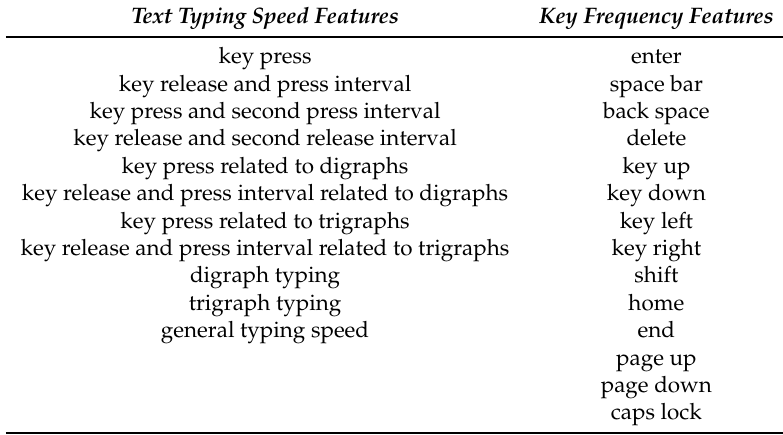
Figure 2. Architecture of the ANN for the sentiment analyzer agent with keystroke dynamic data. Table 1. Text typing speed and key frequency features used to train the